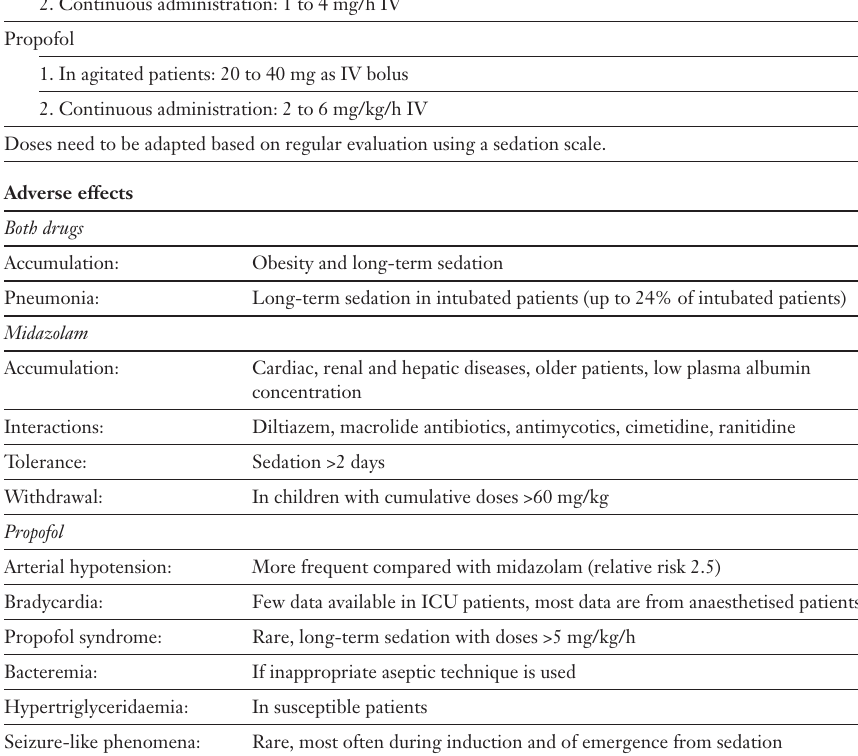
Doses and adverse effects of the most frequently used seda- tives – midazolam and propofol – in critically ill